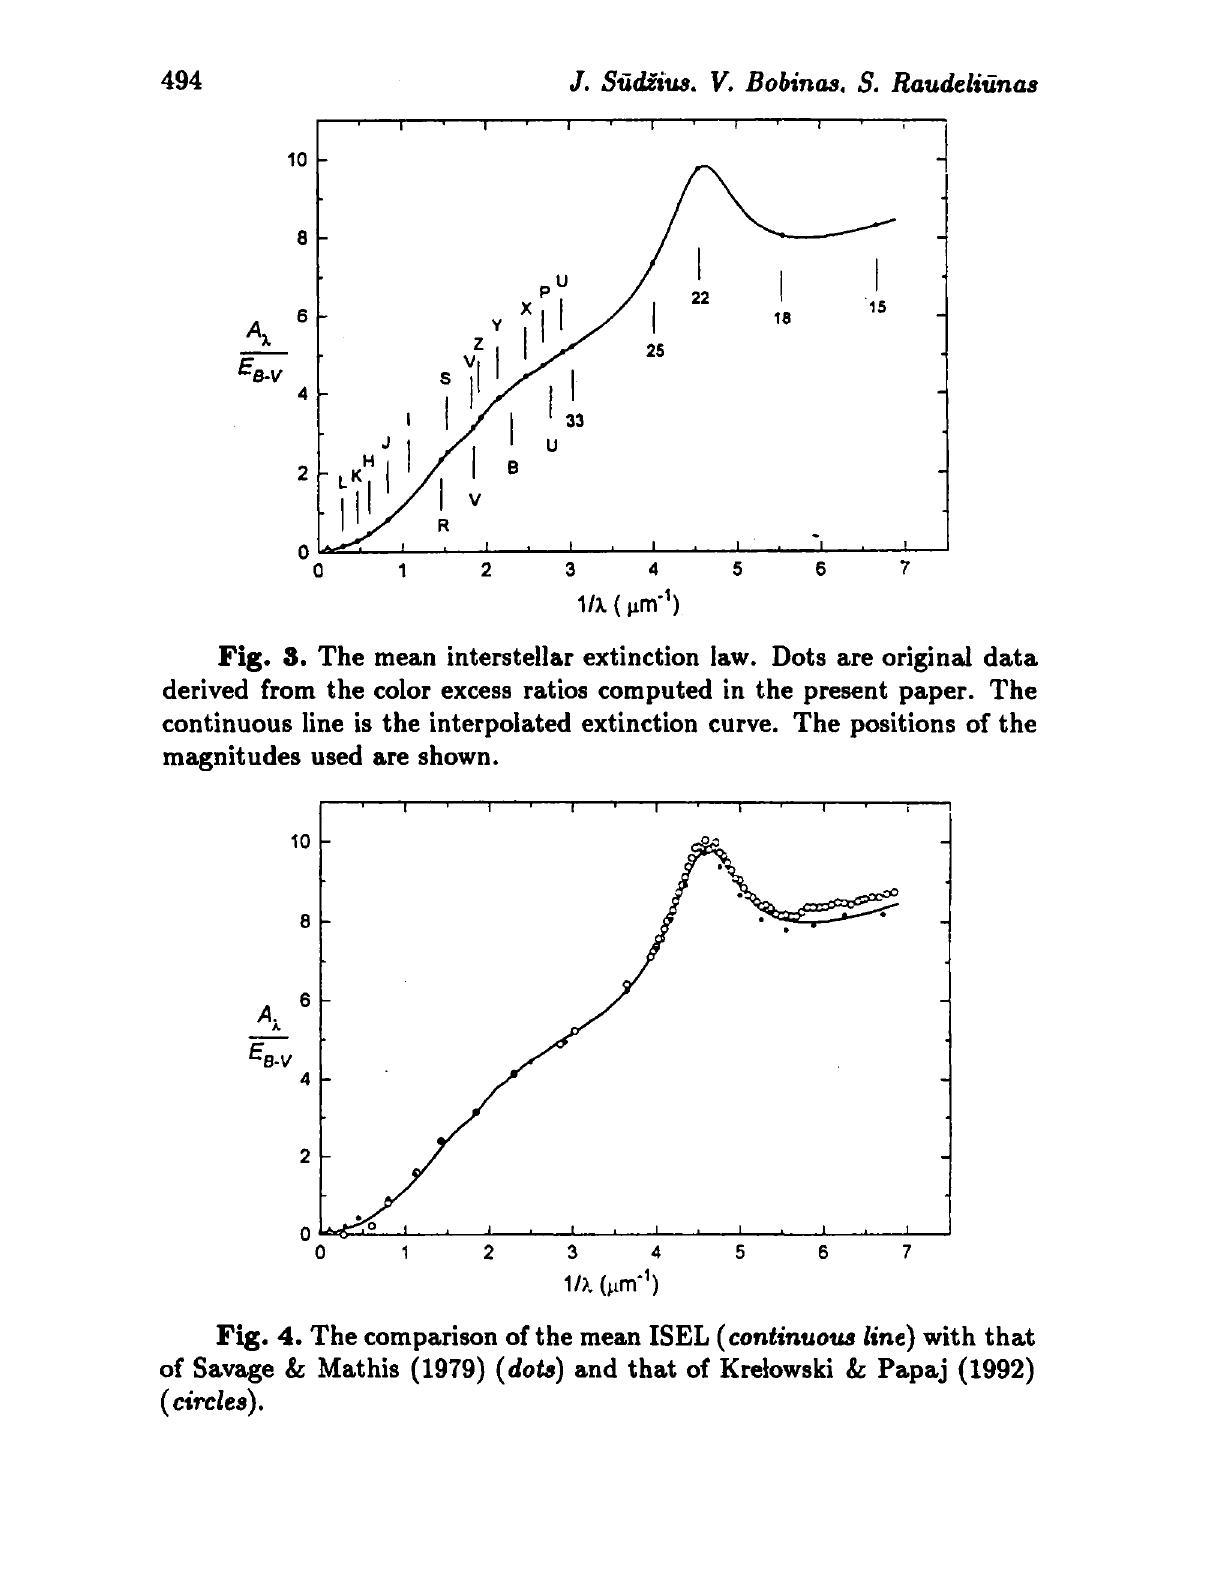
Fig. 4. The comparison of the mean ISEL ( continuous line) with that of Savage & Mathis (1979) (dots) and that of Krelowski & Papaj (1992)